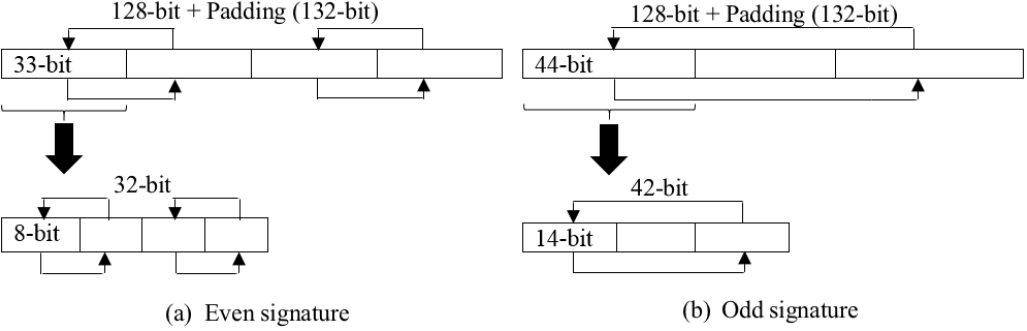
Figure 5. Camouflage